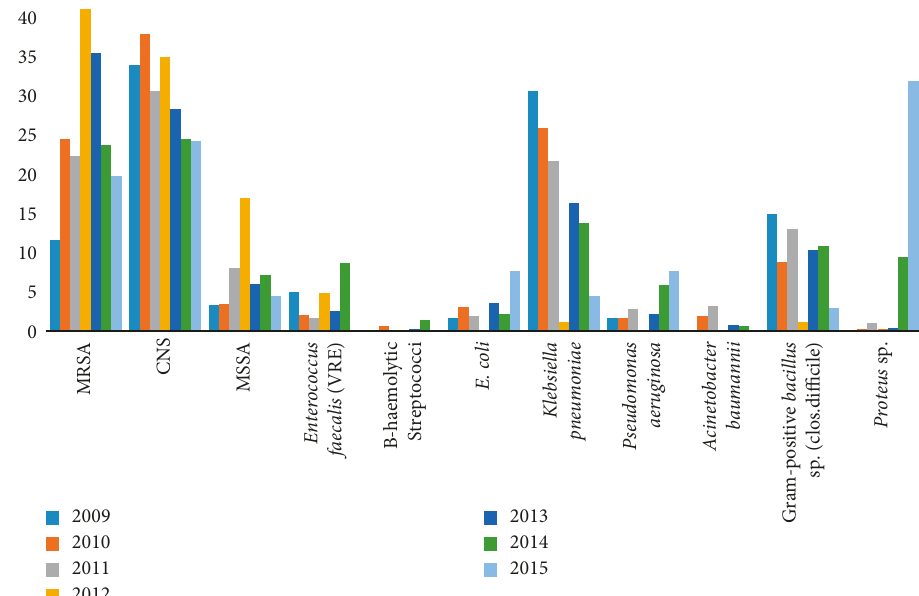
Figure 4: Distribution of the type of organism isolated according to the year of monitoring from different hospitals (2009–2015) in Assiut